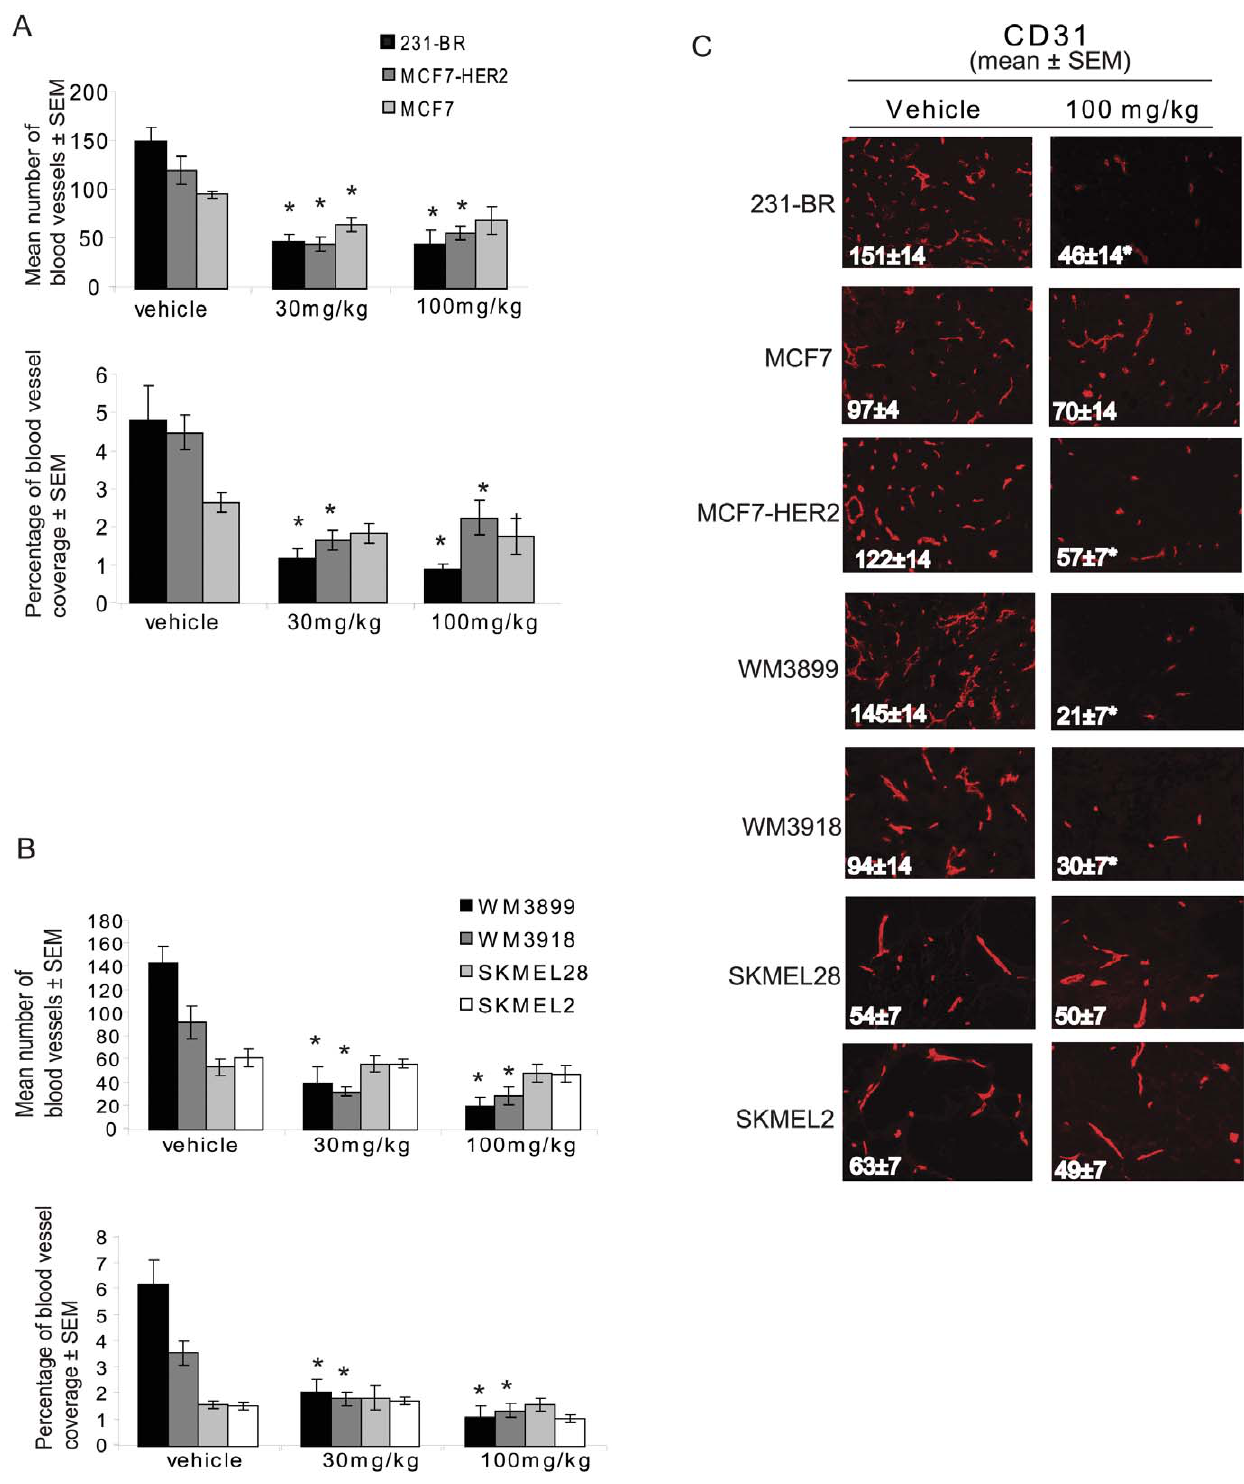
Figure 4. Anti-angiogenic effect of pazopanib on primary tumor xenografts correlates with B-Raf status. Panel A: Breast cancer xenografts. Panel B- Melanoma xenografts. In each panel the top graph represents the mean number of blood vessels per tumor section (n=5 mice) 6 SEM and the bottom graph represents the percentage of area covered by blood vessels (n=5 mice) 6 SEM for the vehicle treated group, the 30 mg/kg group and the 100 mg/kg group. Panel C: Representative photographs of CD31 staining for vehicle and 100 mg/kg treatment groups. Asterisks (*) indicate a statistically significant difference between the pazopanib and vehicle treated groups (p , 0.01). (See Figure S4 for representative photographs of CD31 staining).